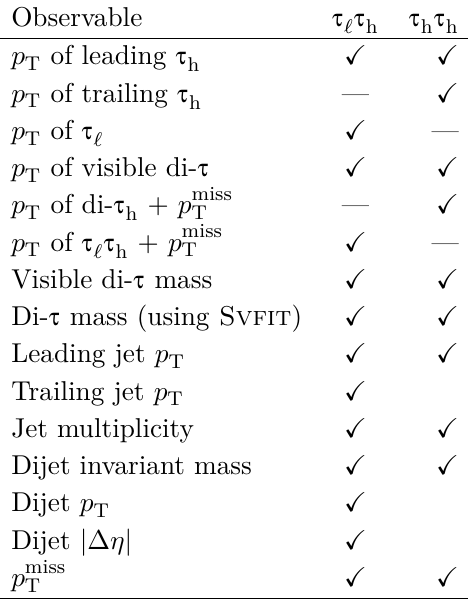
Table 5 . Input variables to the MVA discriminants for the t algorithm is used to estimate the di- t